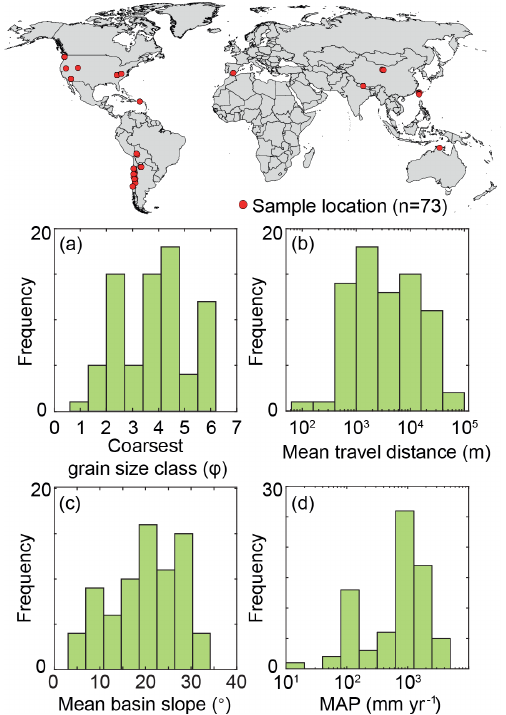
Figure 6. Sample locations and catchment attributes of all catch- ments in the global compilation ( n = 73). (a) Coarsest phi-grain- size classes measured in each study (the smallest grain size was always a sand fraction <2mm). (b) Mean travel distance of sedi- ment, calculated as the arithmetic mean of each grid cell’s travel distance towards the catchment outlet. (c) Mean basin slope of each catchment, calculated as the arithmetic mean of the hillslope an- gles at each grid cell. (d) Mean annual precipitation (MAP) in each catchment, derived from the Global Precipitation Climatology Cen- tre (GPCC) dataset (Meyer-Christoffer et al., 2015).